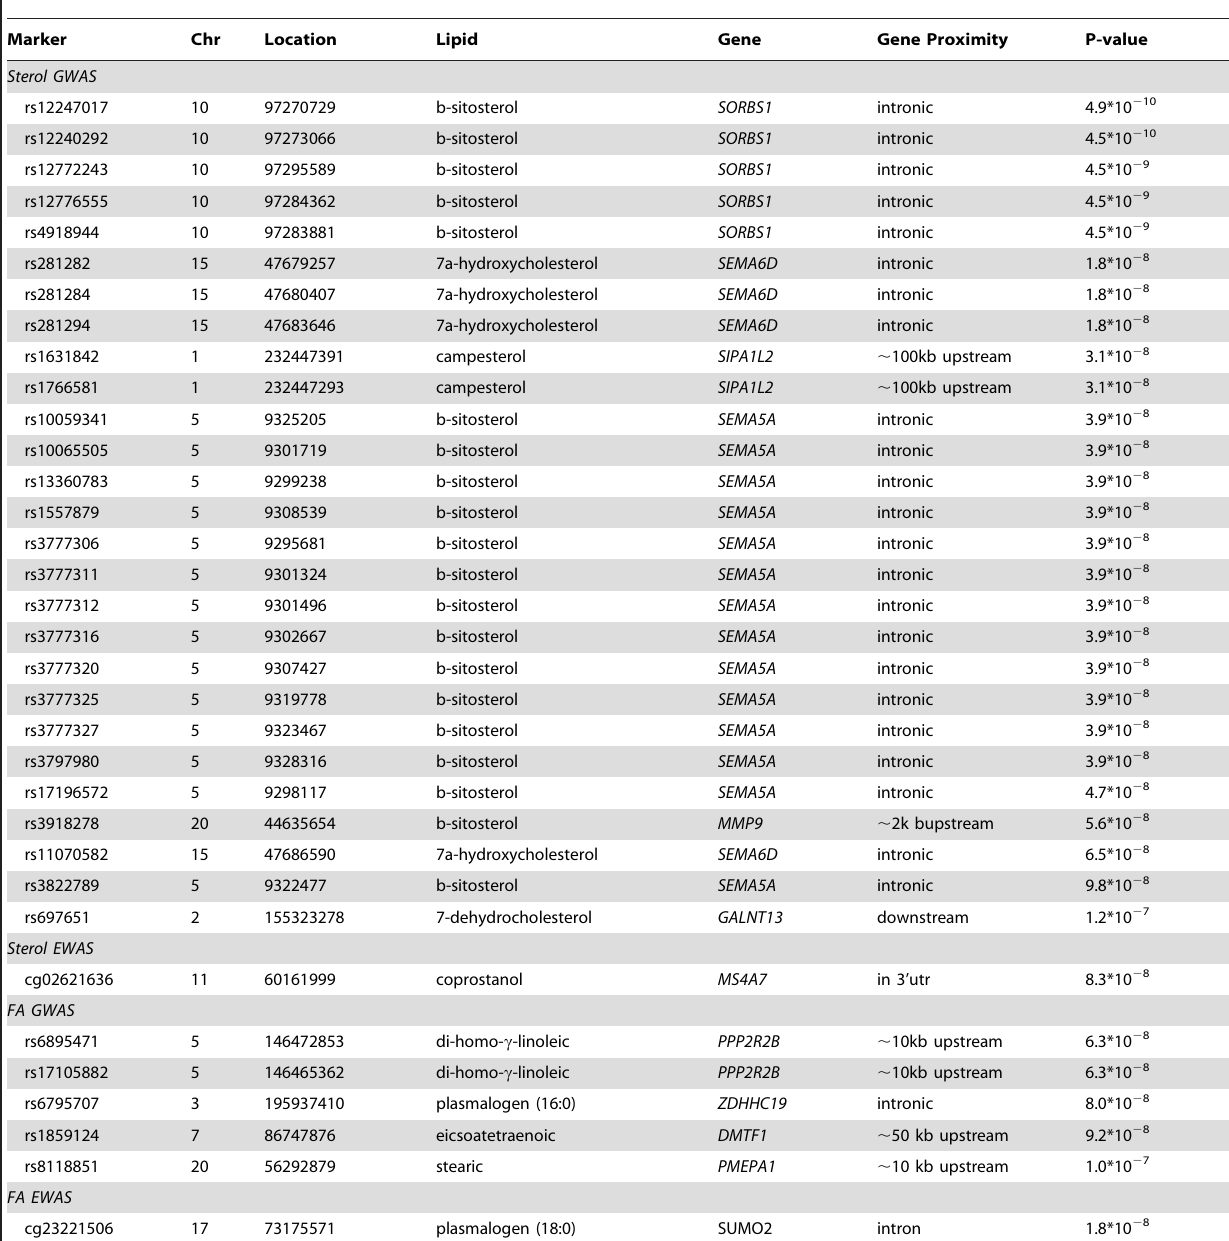
Table 2. Top genome-wide association study (GWAS) and epigenome-wide association study (EWAS) results for fasting sterols and fatty